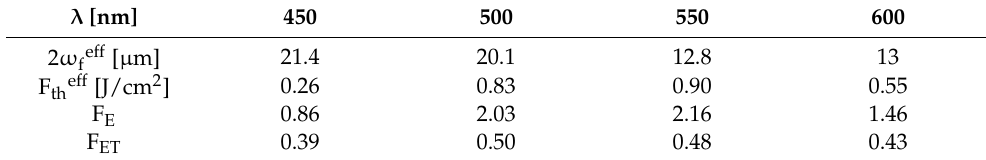
Table 2. Calculation of dual-beam ablation parameters (2 ω feff, F theff ) based on the method of Liu [25] and dual-beam efficiency parameters (F E , F ET ) determined from Equations (3) and (4). λ [nm] 450 500 550 600 2 ω feff [ µ m] 21.4 20.1 12.8 13 F theff [J/cm 2 ] 0.26 0.83 0.90 0.55 F E 0.86 2.03 2.16 1.46 F ET 0.39 0.50 0.48